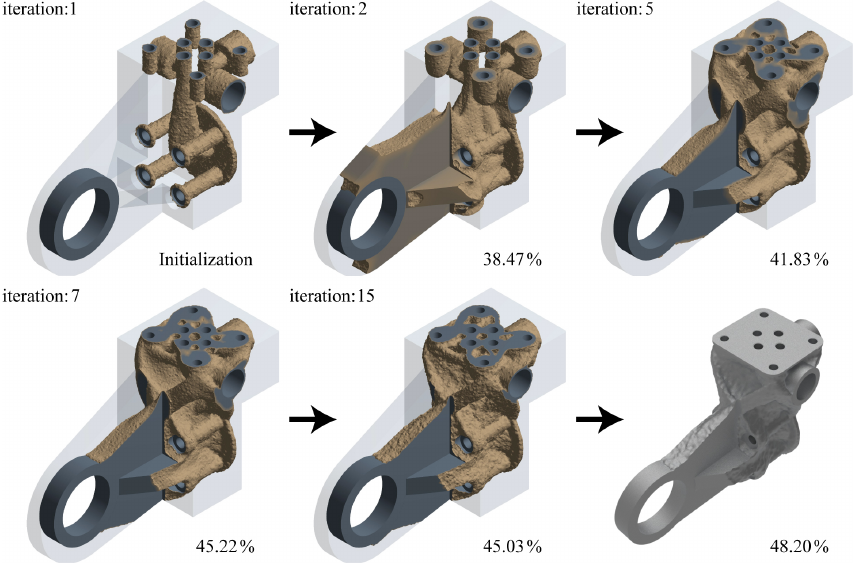
Figure 11. Topology-optimized push model.